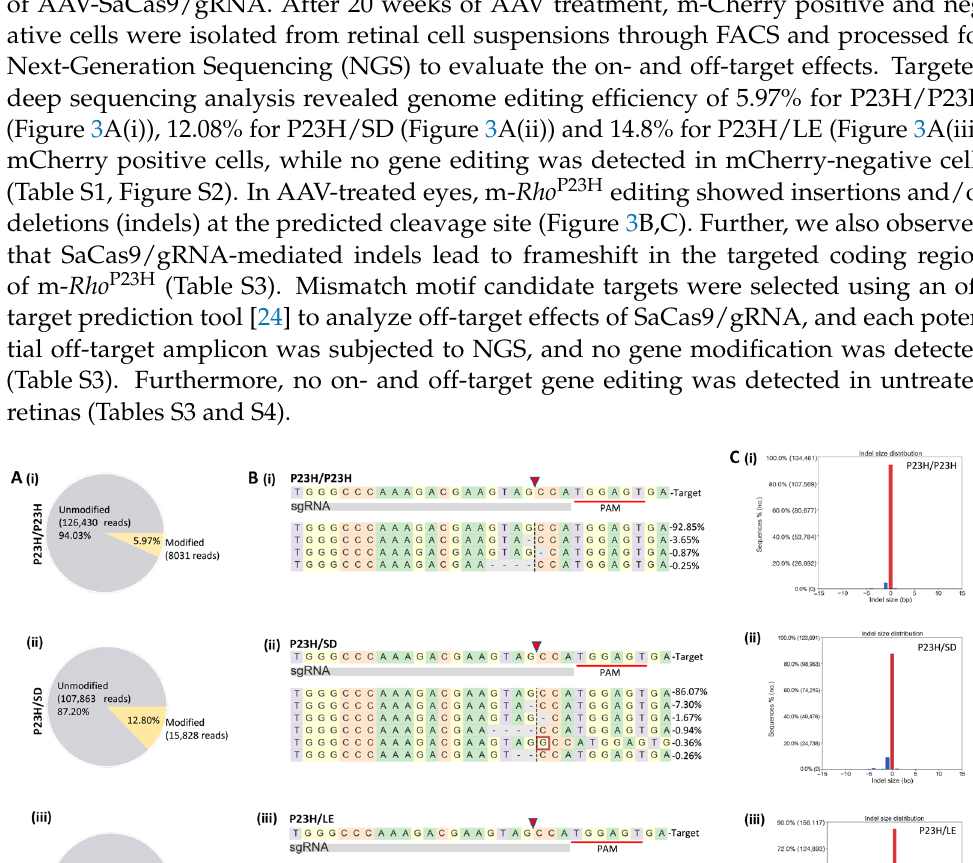
(control) eyes ( ii ). The presence of overlapping base calls with decreased Phred quality scores (grey